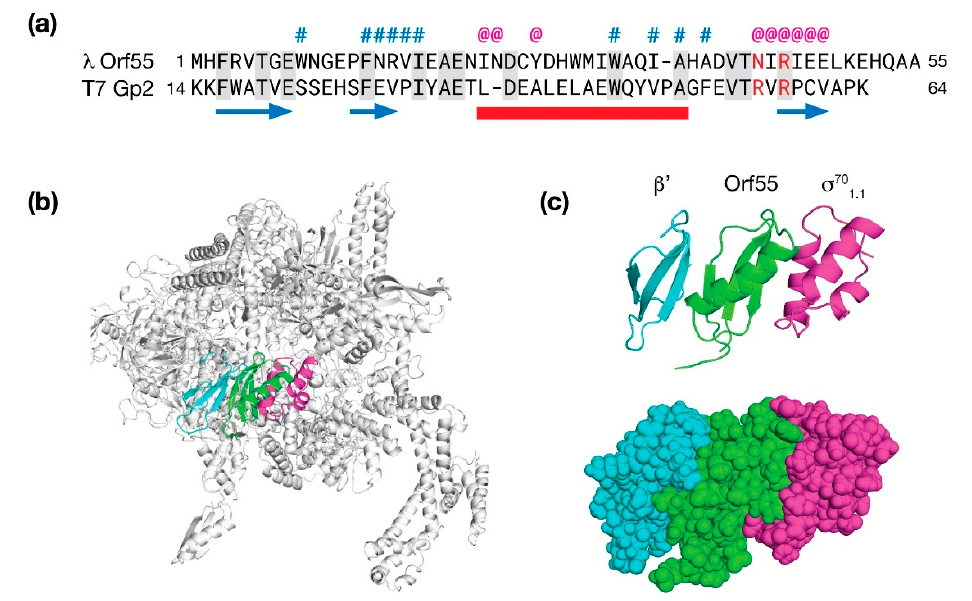
Figure 8. Molecular modeling λ Orf55. High confidence predictions by AlphaFold (pLDDT = 93) and RoseTTAFold (pLDDT = 93) both present Orf55 as a a small α / β protein. From a scan of the PDB for homologs, T7 Gp2 was identified as a candidate. ( a ) Sequence alignment of λ Orf55 and T7 Gp2. The predicted secondary structure is shown underneath the sequence ( β -strands, blue arrows; α -helix, red bar). Sequence identity is denoted by shading. Above the sequence, a # indicates a predicted interaction with the RNAP β (cid:48) subunit and a @ indicates a predicted interaction with the 1.1 domain of the general sigma factor, σ 70 . ( b ) The Rosetta software suite was used to refine a molecular model of Orf55 (green) situated in RNAP. Numerous contacts are made between Orf55 in the model with the β (cid:48) subunit (blue) and σ 70 (magenta). ( c ) Ribbon and space-filling diagram detail of Orf55 flanked by the RNAP β (cid:48) subunit and σ 70